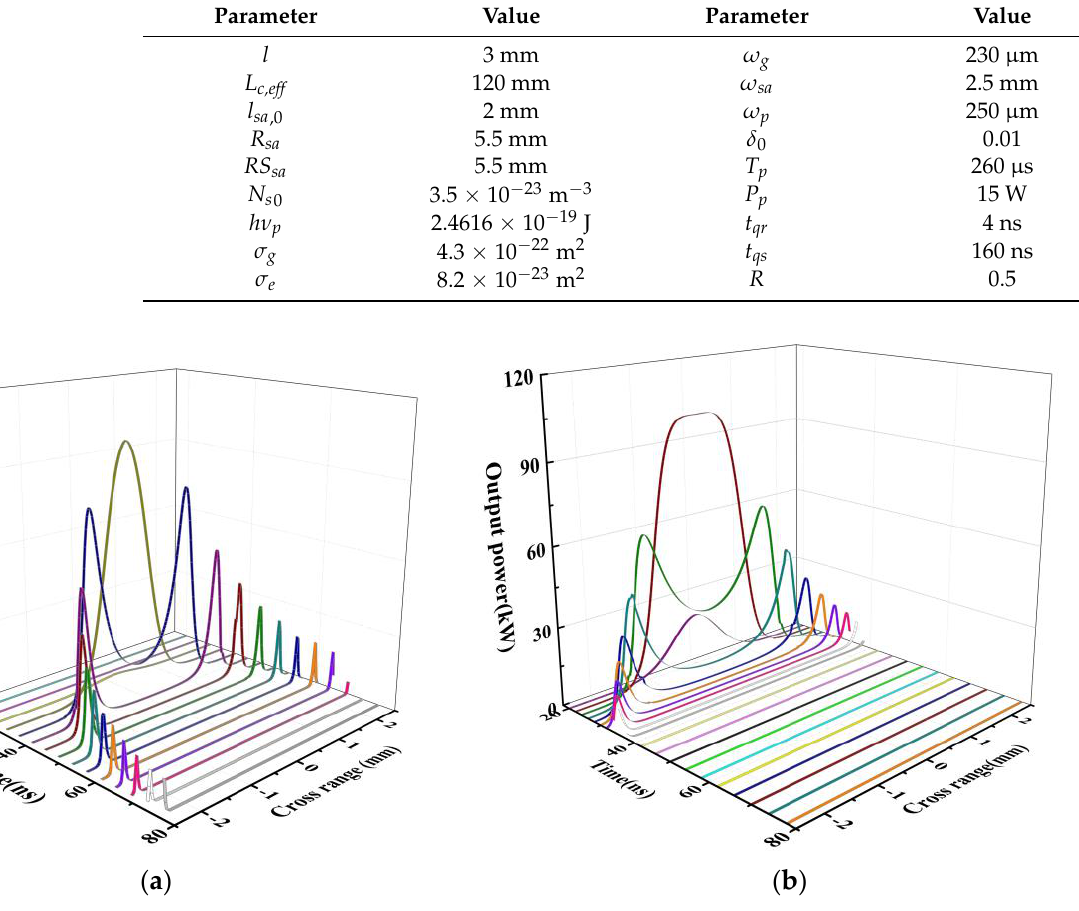
Figure 4. Evolution of the radial intensity distribution of the laser output along with the time ( a ) V hl / V λ /4 = 1.4; ( b ) V hl / V λ /4 = 1. (Note: Different colors represent the radial intensity distribution of laser output at different times) Table 1. Parameter values used in the theoretical simulations.